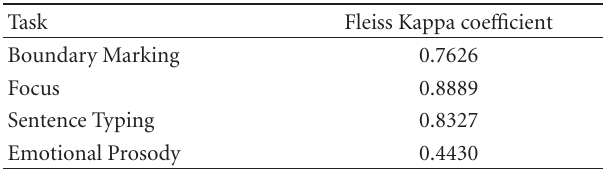
Table 7: Interrater agreement results, obtained through a Fleiss Kappa